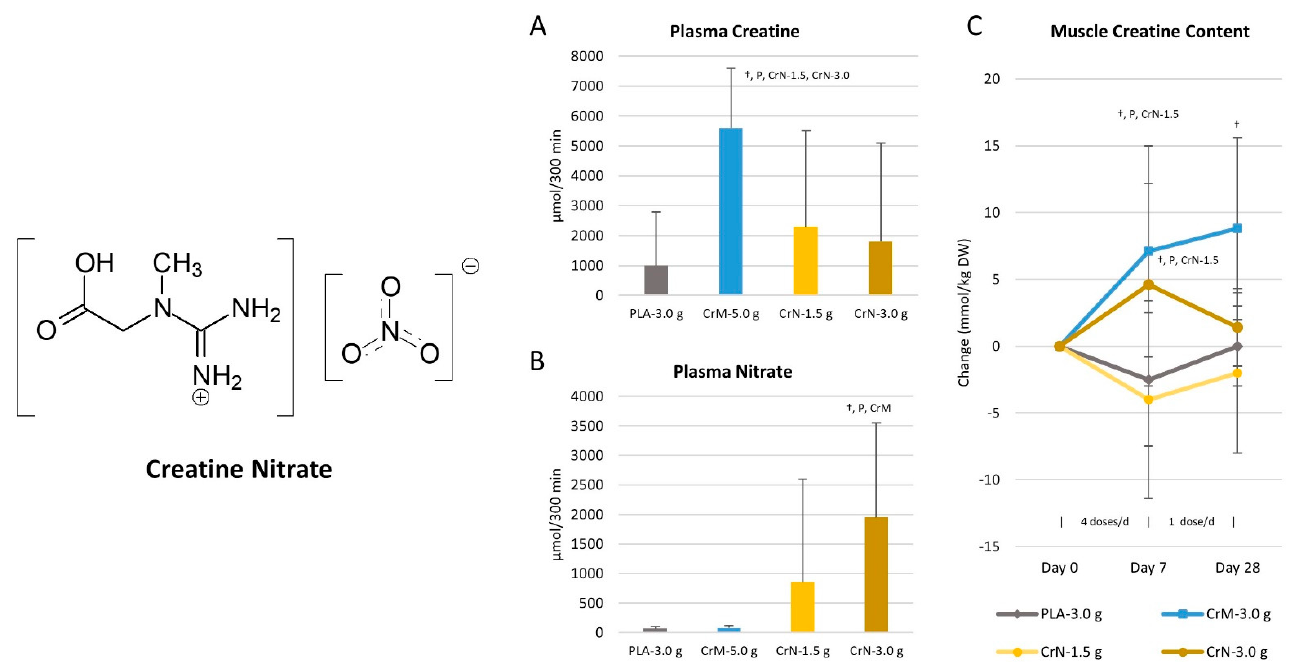
Figure 12. Chemical structure of creatine nitrate. ( A , B ) show 5 h area under the curve data after plasma creatine and plasma nitrate, respectively. ( C ) shows mean changes in muscle creatine con- tent with 95% confidence intervals after 7 days of loading 4 doses/day and 21 days of ingesting 1 those/day. † Represents significant change from baseline, PLA and P represent placebo, CrM repre- sents creatine monohydrate, and CrN represents creatine nitrate.